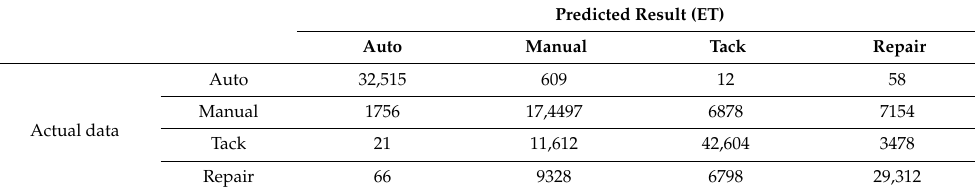
Table 5. Confusion matrix of the ET classification model.